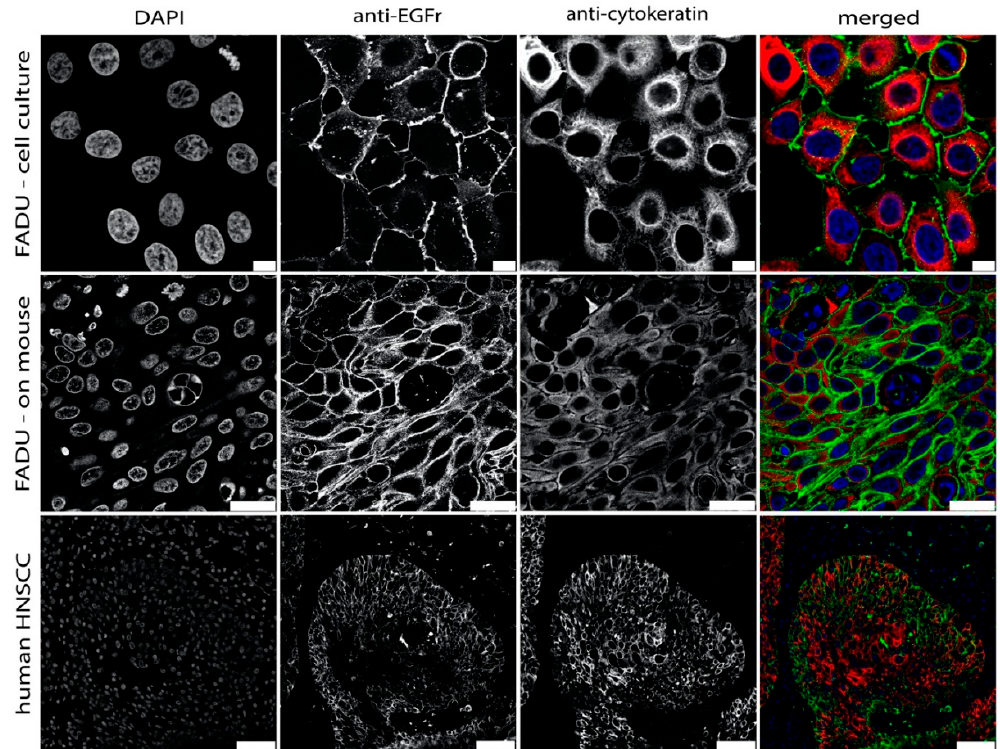
Figure 3. EGFR expression in FaDu cell tissue culture, FaDu transplanted in nude mice and in human poorly differentiated squamous carcinoma. The samples were stained with EGFR antibody (green) and counterstained with an antibody against cytokeratin (red) to confirm the epithelial origin of the tumor (carcinoma), and with DAPI for nuclear stain (blue). Scale bars: FADU cell culture - 10 µm; FADU on mouse - 25 µm; human HNSCC - 50 µm.